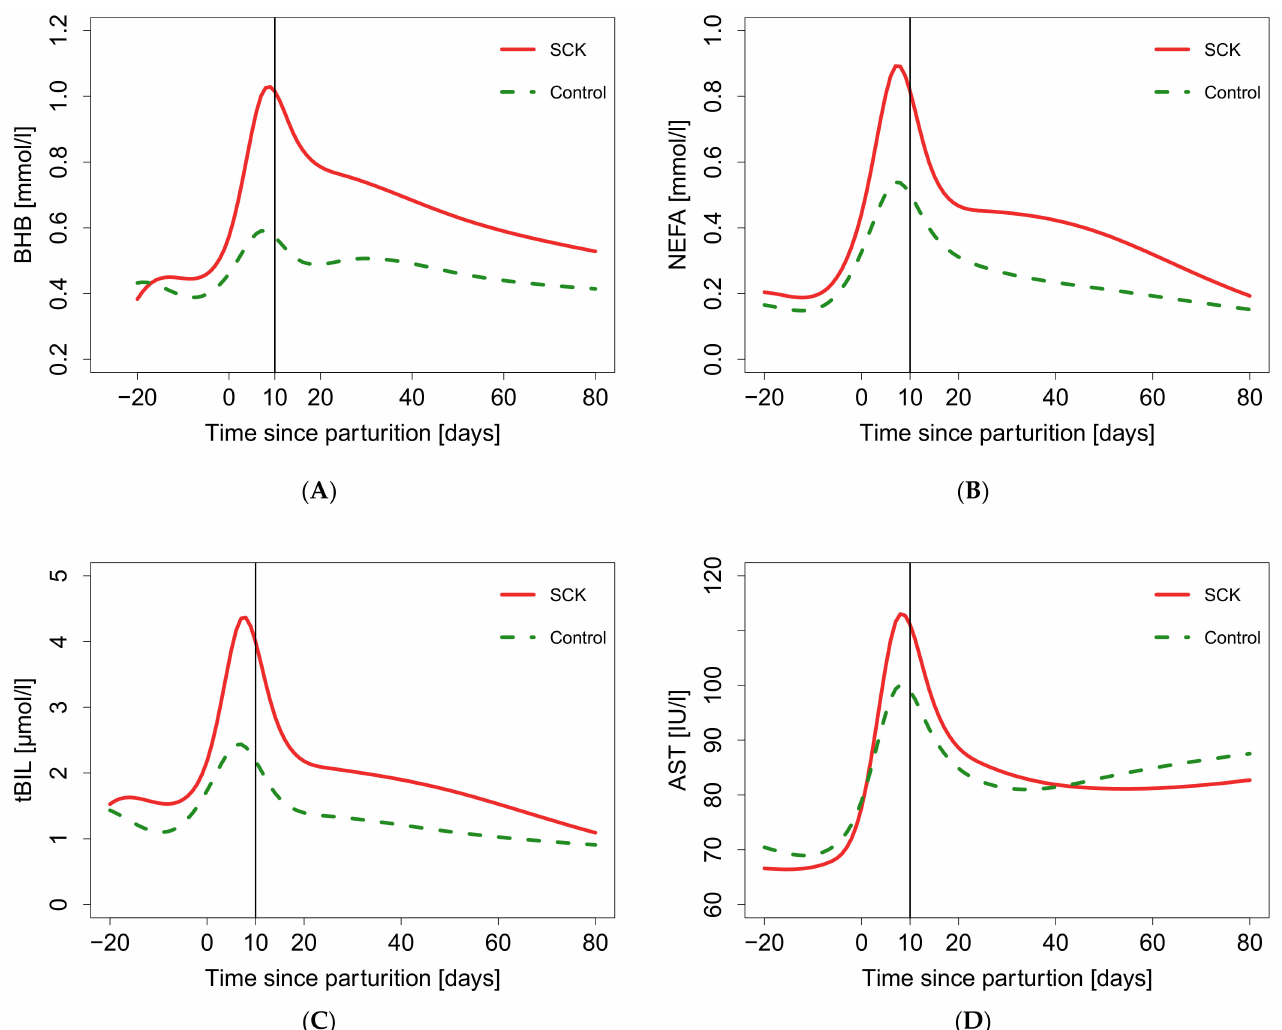
Figure 3. Natural cubic spline fit of biomarkers for subclinical ketosis (SCK) (BHB > 1.2 mmol/L) and control (BHB ≤ 1.2 mmol/L) group between 20 days ante partum and 80 days post partum. The 10th day p.p. is indicated by a vertical line: ( A ) Natural cubic spline fit of beta-hydroxybutyrate (BHB); ( B ) Natural cubic spline fit of non-esterified fatty acids (NEFA); ( C ) Natural cubic spline fit of total bilirubin (tBIL); ( D ) Natural cubic spline fit of aspartate aminotrans- ferase